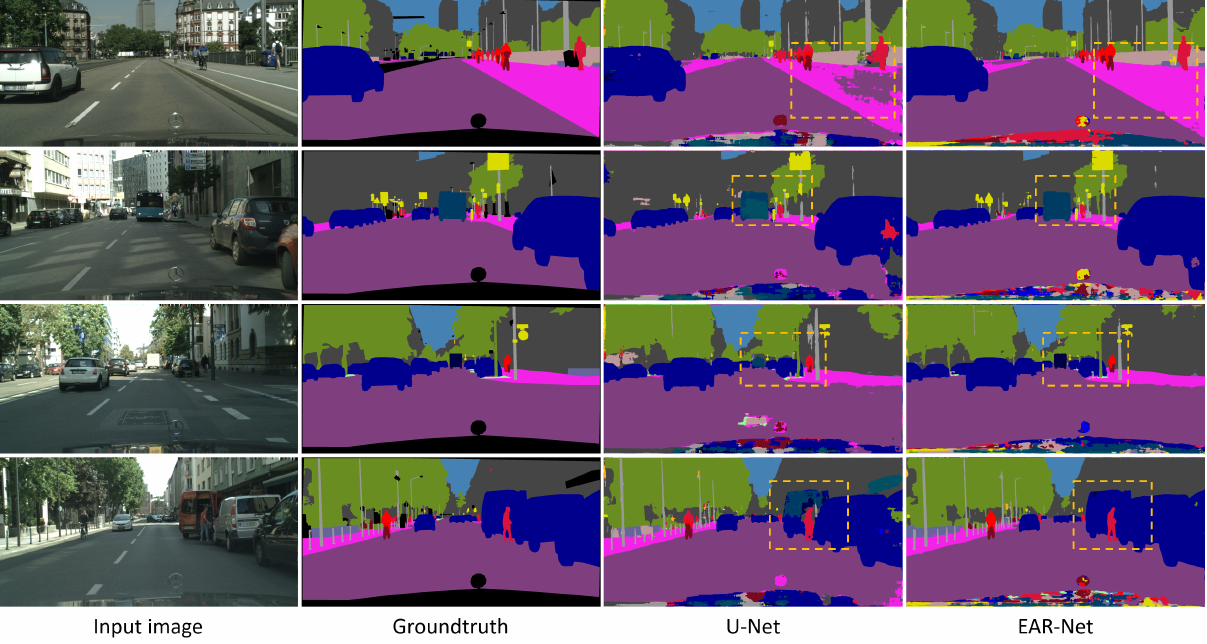
Figure 9. Visual comparisons of multiple objects on the Cityscapes validation set. The orange box shows the section where the EAR-Net achieves a more accurate segmentation result than the